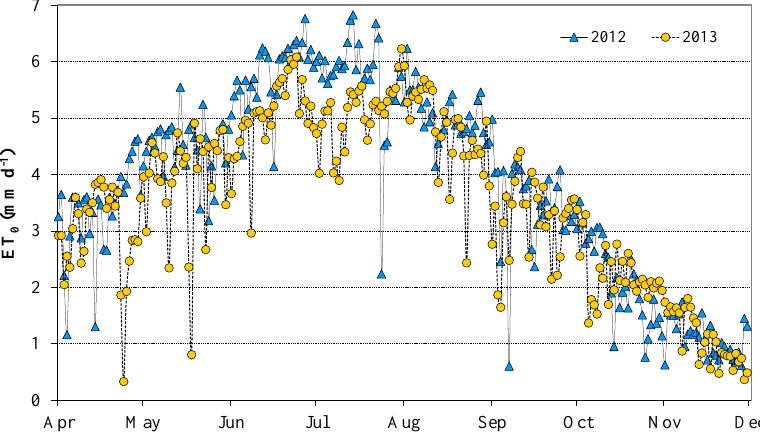
Figure 5. ET 0 daily rates during 2012 and 2013 observation periods.